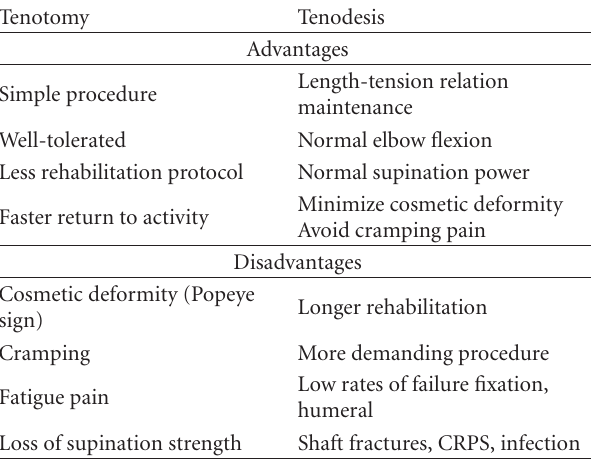
Table 1: Tenotomy versus tenodesis: advantages and